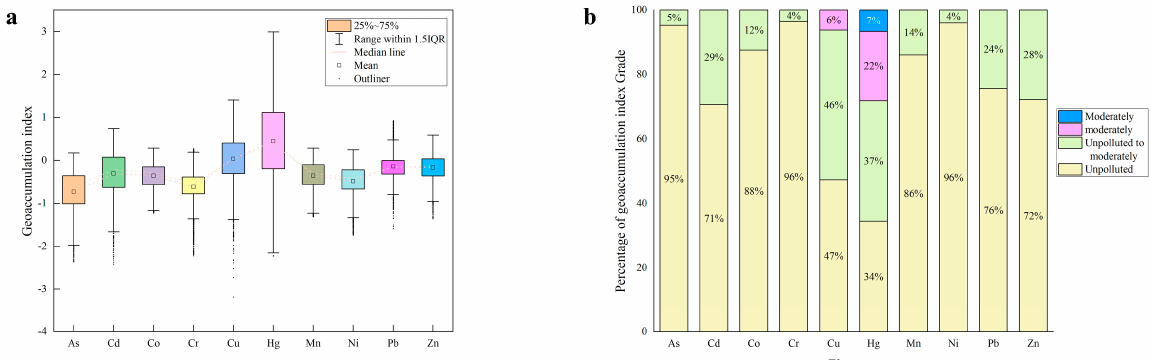
Figure 8. ( a ) Enrichment factor index (EF) of HMs in Farmland soil and ( b ) the percentage of Enrichment factor index grade (%).